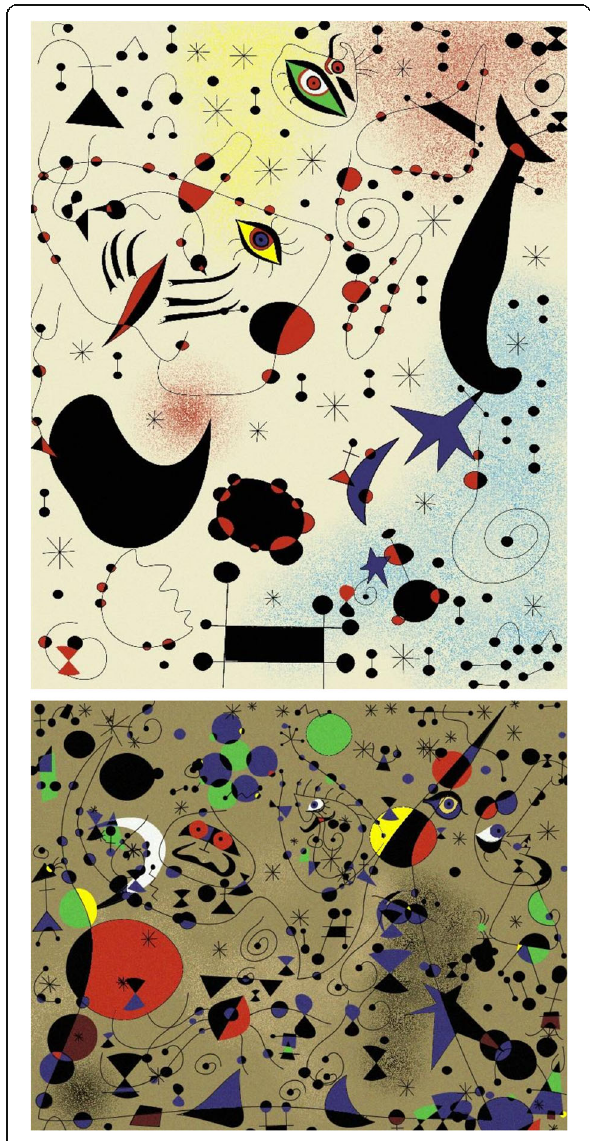
Fig. 23 Generated images of Miro ’ s “ Ciphers and Constellations in Love with a Woman ” (top) and “ Poetess ” (bottom)